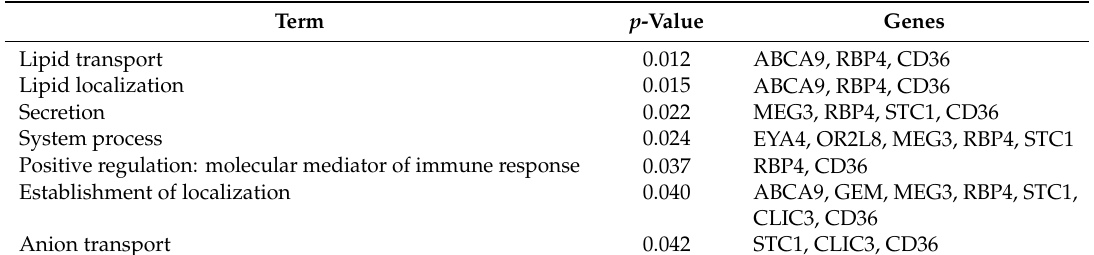
Table 3. Significant biological process between non-responders and